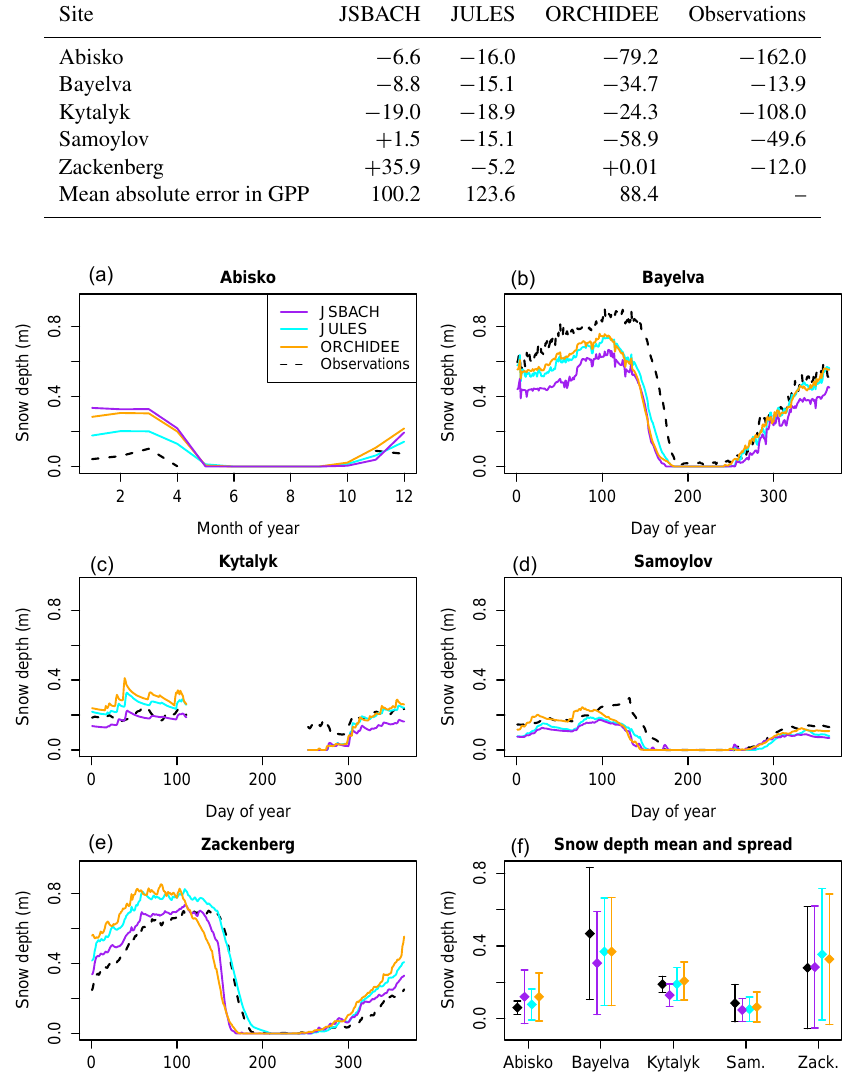
is between 0.03 and 0.1 Wm − 1 K − 1 at the sites with